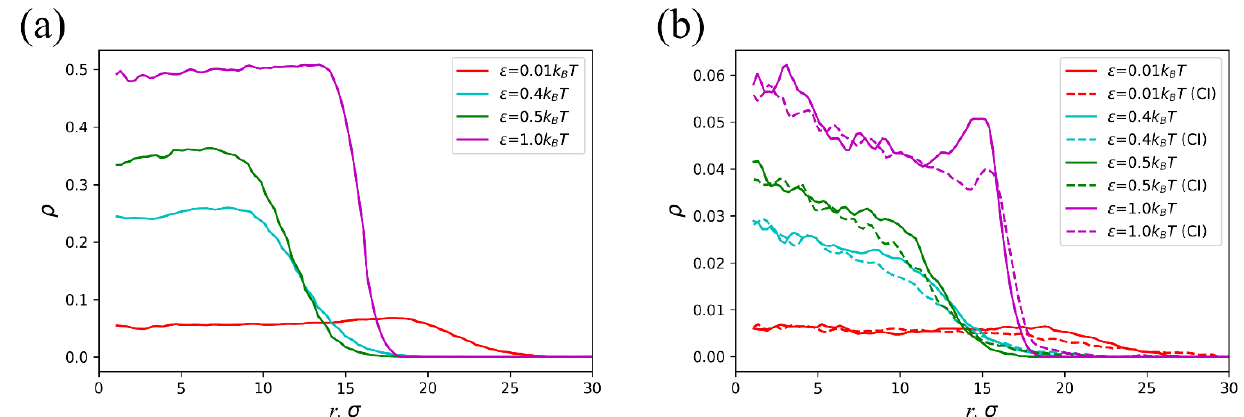
Figure 8. ( a ) Polymer volume fraction, ( b ) volume fraction of the network charged groups (solid) and counterions (dashed) as functions of the radial coordinate r at different ε values. The molecular weight and subchain length of the microgel are N = 100,000 and M = 10, respectively. The initial aspect ratio and the fraction of charged groups are A = 10 and f = 10%.